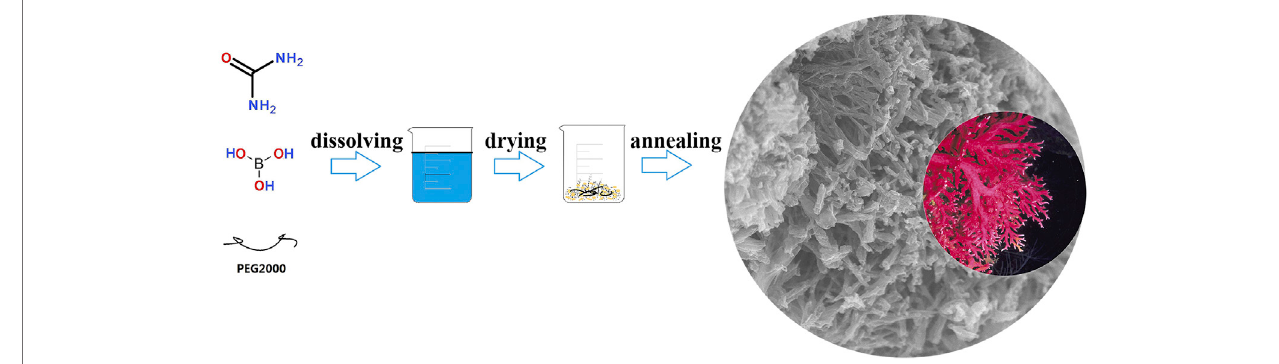
FIGURE 1 | Schematic of the synthesis process of BN-CCF.